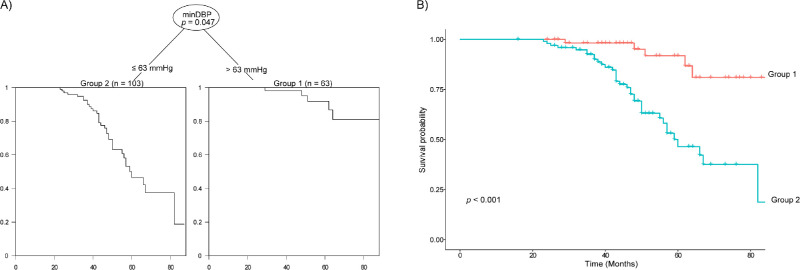
(A) Decision tree analysis for progressive macular GCIPL thinning; (B) Kaplan-Meier analysis showing significant differences in the progression rate between the two groups defined by the tree analysis. MinDBP, minimum diastolic blood pressure.